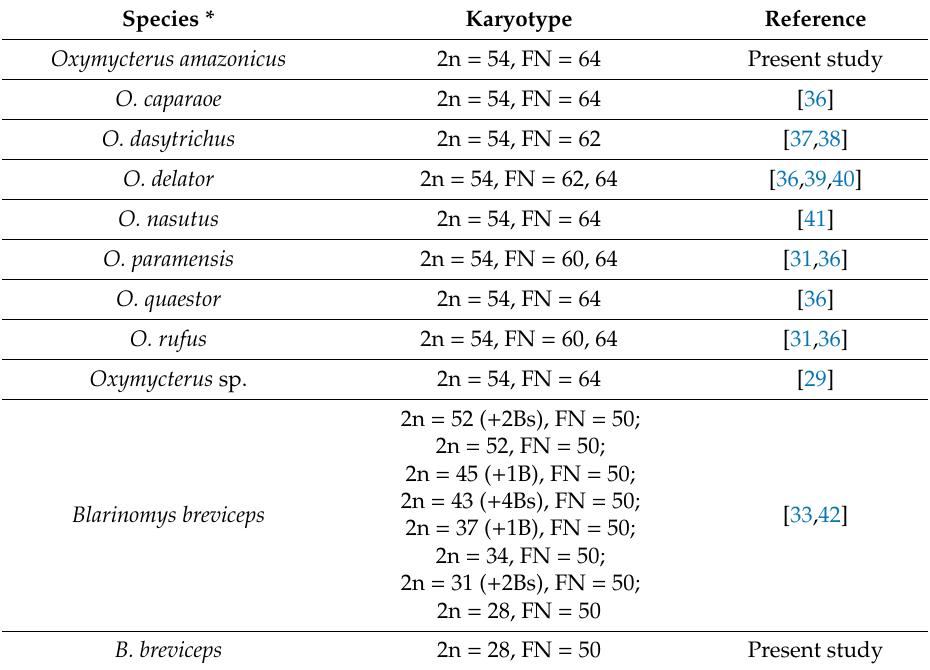
Table 2. Cytogenetic data available in the literature and obtained in the present study for Oxymycterus and Blarinomys genus. Abbreviations: 2n, diploid number; FN, fundamental autosomal number; B, B chromosomes. Numbers within parenthesis refer to the number of B